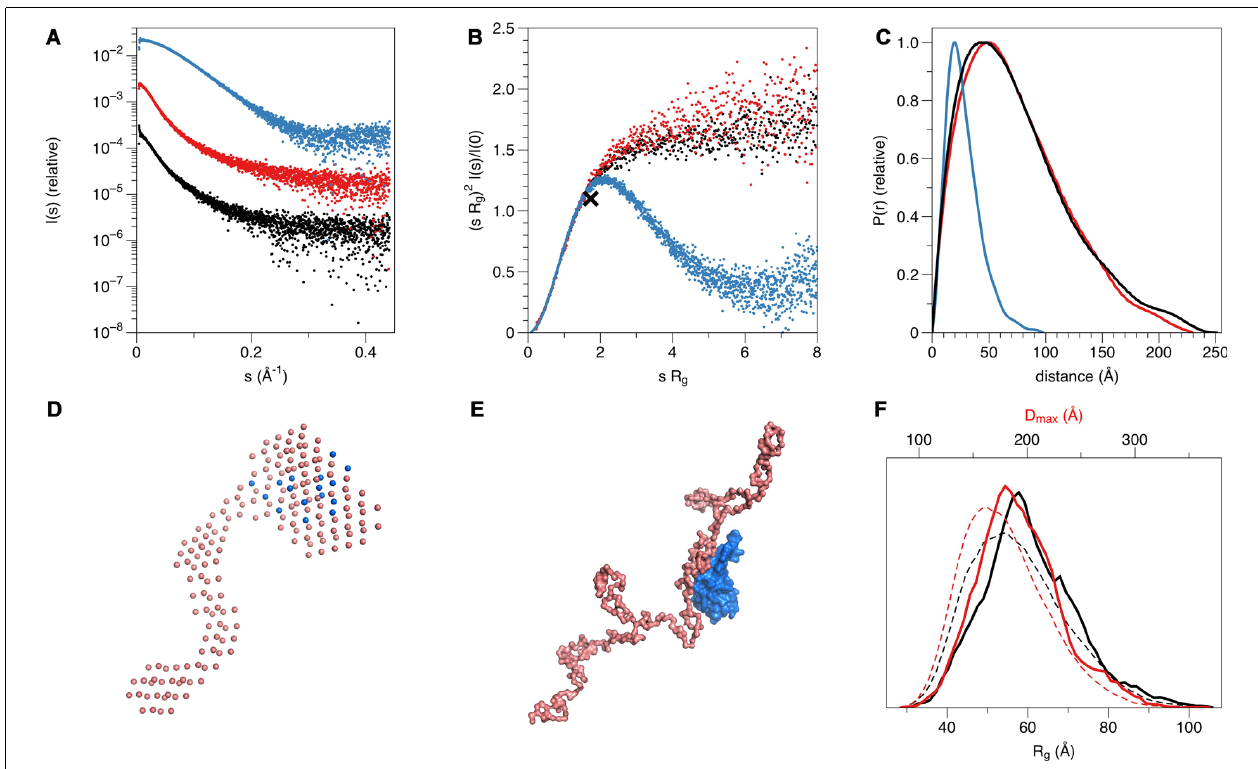
FIGURE 5 | Structure of the complex in solution. (A) Small-angle X-ray scattering (SAXS) scattering curve. PRX-C, red; β 4-FNIII-3, blue; complex, black. (B) Dimensionless Kratky plot. The black cross indicates the theoretical peak position for a folded, perfectly globular protein. (C) Distance distribution function. (D) Multi-phase model from MONSA. PRX-C, pink; β 4-FNIII-3, blue. (E) Rigid-body fit between a chain-like model of PRX-C (pink) and the integrin crystal structure (blue). (F) EOM analysis for PRX-C. Dashed lines, theoretical distribution for a random coil; solid lines, the ensemble for PRX-C. Maximum dimension is shown in red and radius of gyration in black. PRX-C is slightly more elongated than a random